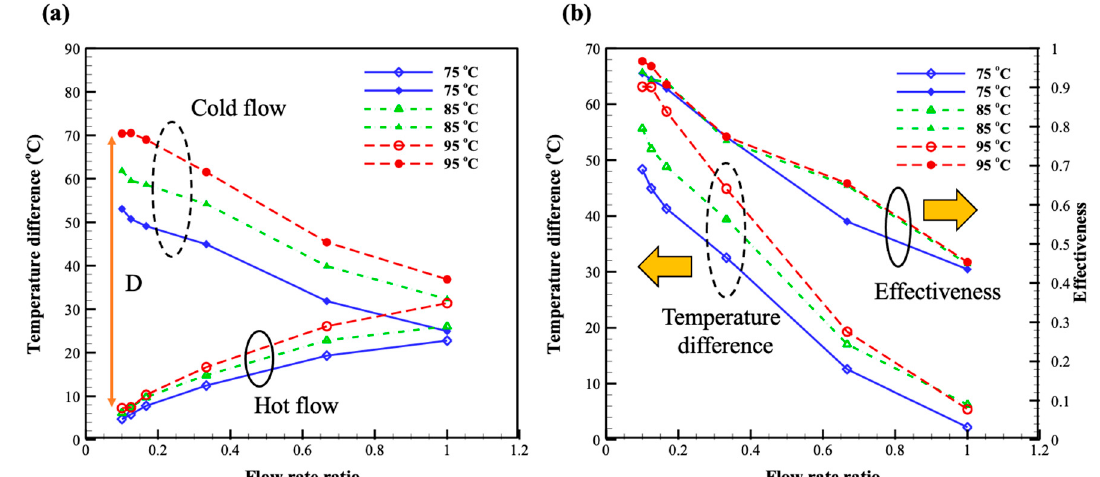
Figure 6. The temperature difference plot for different flow rate ratios and effectiveness ( a ) the temperature difference between inlet and outlet of hot (solid line) and cold (dash line) fluid. ( b ) the temperature difference (solid line) between hot and cold fluid and effectiveness (dash line).